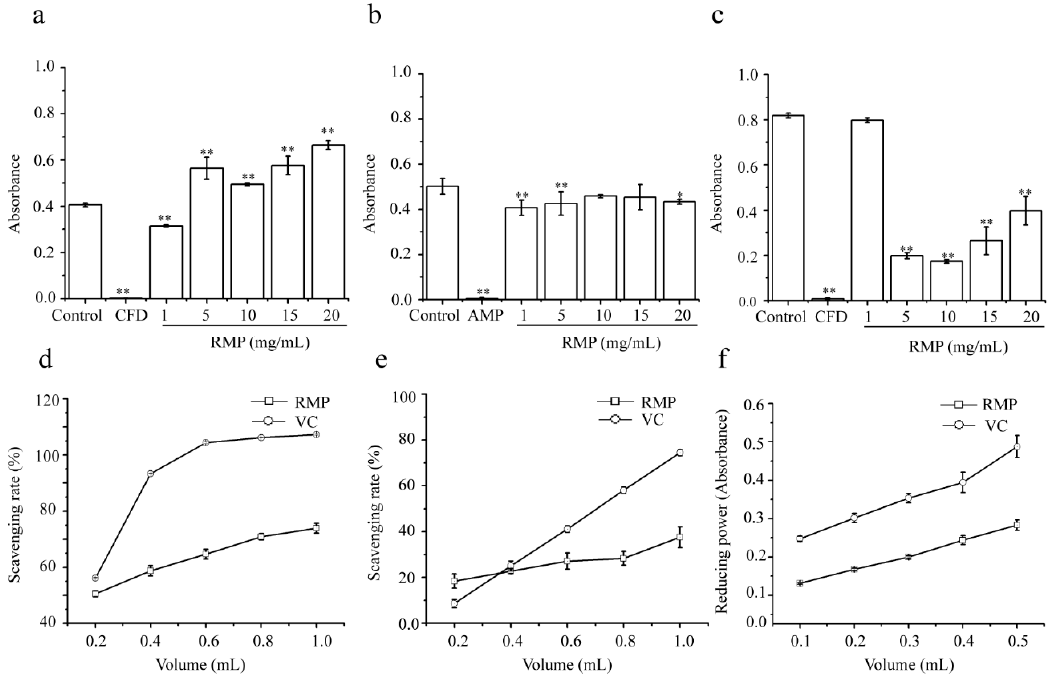
Figure 4. Antibacterial and antioxidant activity of RMPs. Effects of RMPs on the proliferation of ( a ) E. coli , ( b ) S. aureus , and ( c ) P. aeruginosa . ( d ) Hydroxyl radical scavenging activity; ( e ) superoxide ‐ radical scavenging activity; and ( f ) reducing the power of RMPs. Values shown are means ± SD obtained from three measurements. Abbreviations: CFD, Cefobid; AMP, ampicillin; and VC, vitamin C. ** P < 0.01 and * P < 0. 05.